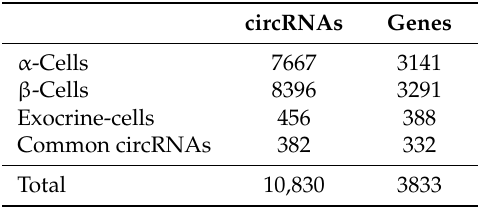
Table 1. High confidence circular RNAs (circRNAs) in α -, β -, and exocrine cells. The high